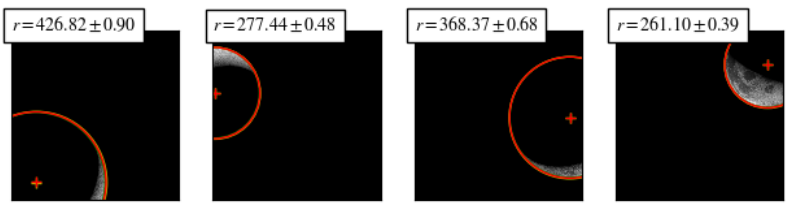
Figure 5. Examples images in the dataset. ( 1 ) Moon circle with terminator, ( 2 ) full disk, ( 3 ) scarce illumination, ( 4 ) partial frame occlusion, ( 5 ) partial frame occlusion with dim light.